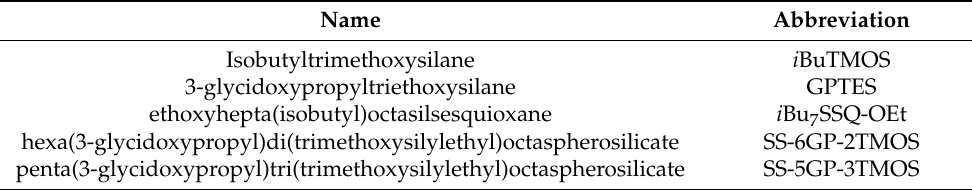
Table 1. Silsesquioxane, spherosilicate, and silane coupling agents used in this study.